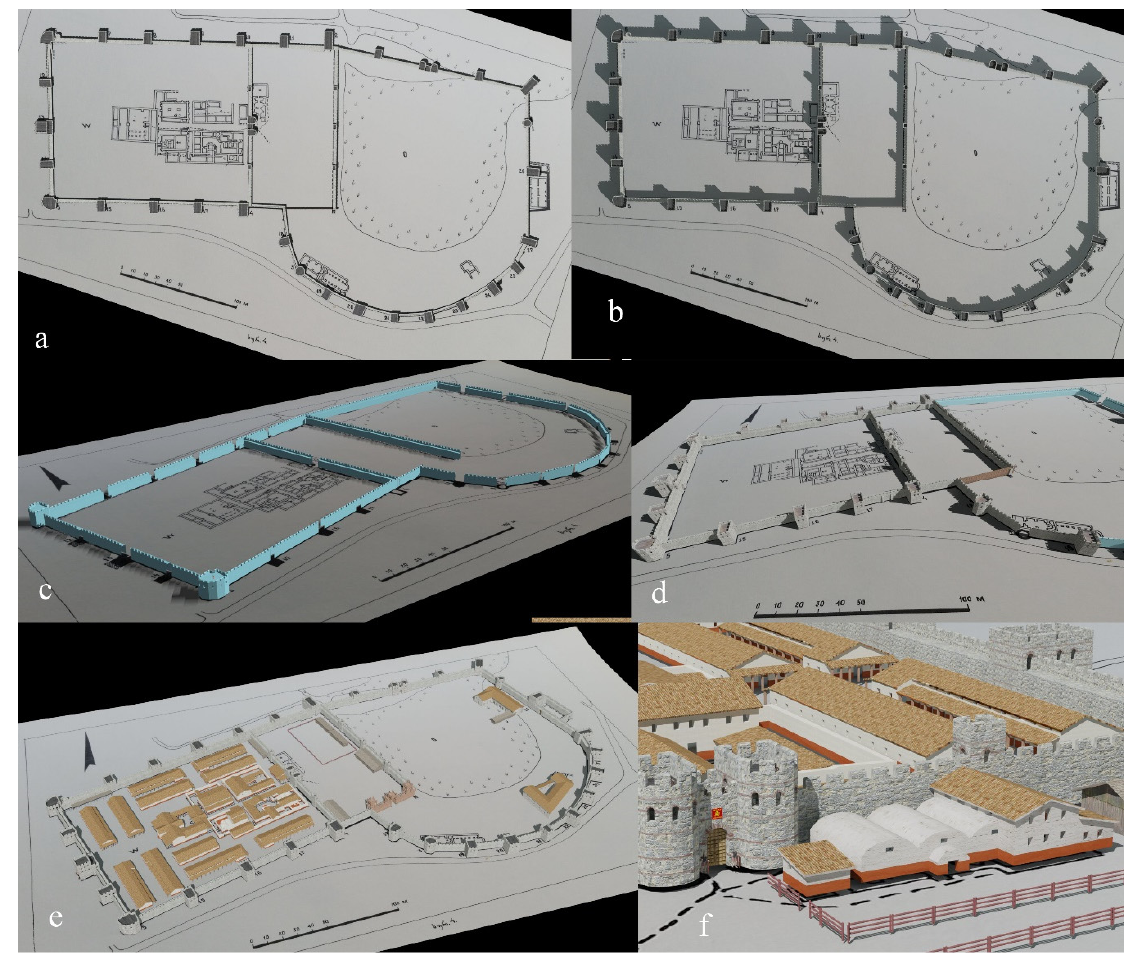
Figure 4. Stages of modeling: ( a ) creating the outlines of walls and towers; ( b ) raising the contours of the walls to a certain height; ( c , d ) texture mapping; ( e ) creation of internal planning; ( f ) reconstruction of small artistic details.